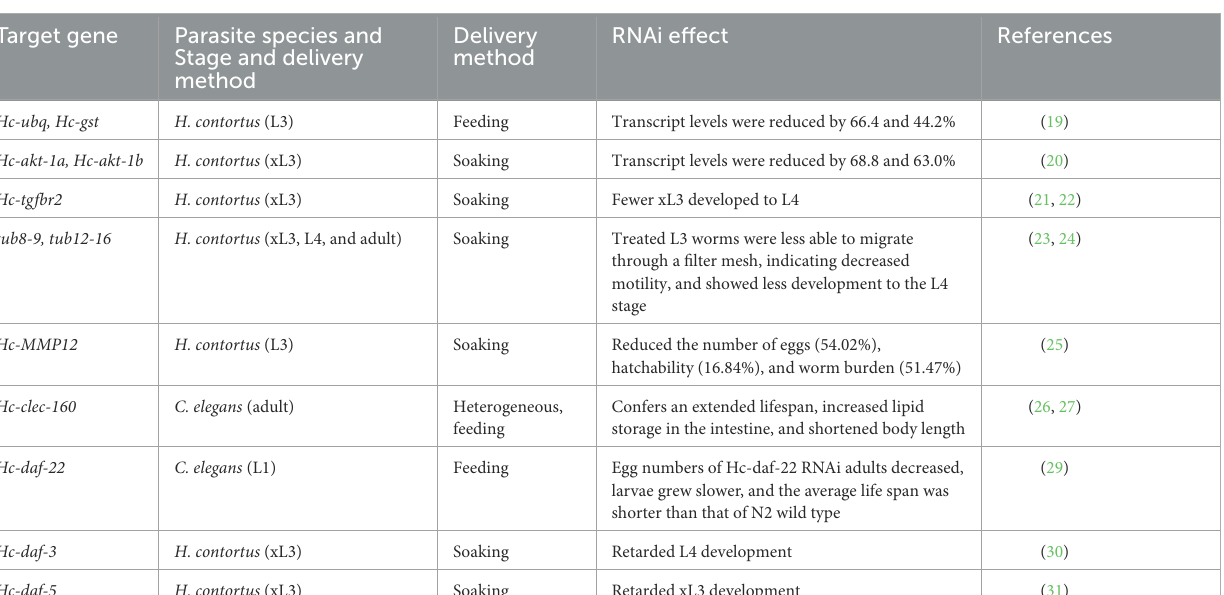
TABLE 1 Reported methods for the study of gene function using RNAi in parasitic